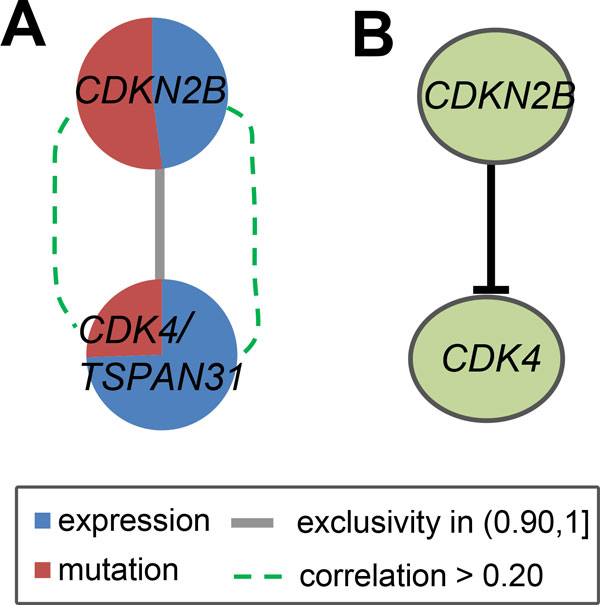
The second module identified by iMCMC and the corresponding known pathway in the GBM data. (A) Red and blue colors in the vertex represent the proportion of gene's coverage and the influence of its mutation status on other genes. Thick gray line shows that gene CDKN2B and the metagene CDK4/TSPAN31 are approximately exclusive (with exclusivity more than 0.90), whereas the dashed green curve represents existence of relative correlation between the expressions of the corresponding pair of genes. It is similar for the following figures. (B) CDK4 is suppressed by CDKN2B in the RB signaling pathway, where the interaction is as reported in [2].